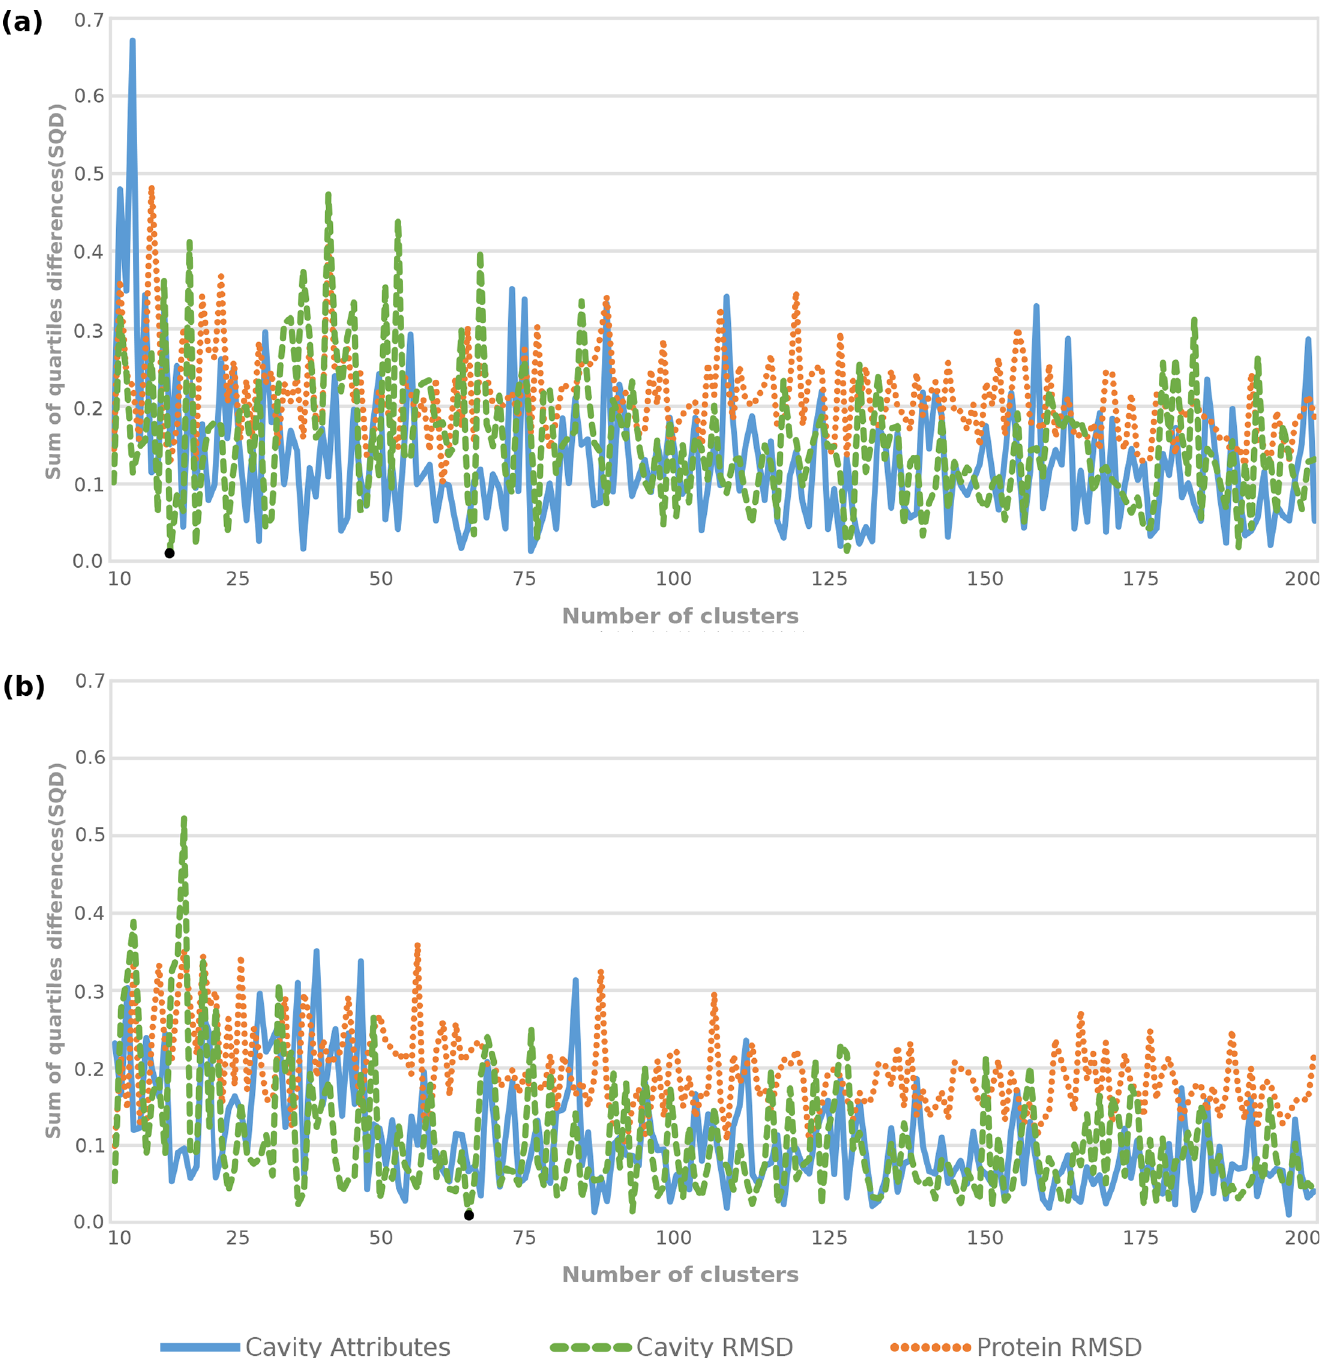
Fig 4. Comparative performance of partitioning clustering methods for the three data sets under study. Variations in the SQD values as a function of the number of clusters for k -means and k -medoids are showed in the graphs (a) and (b), respectively. The black points identify the optimal partitioning